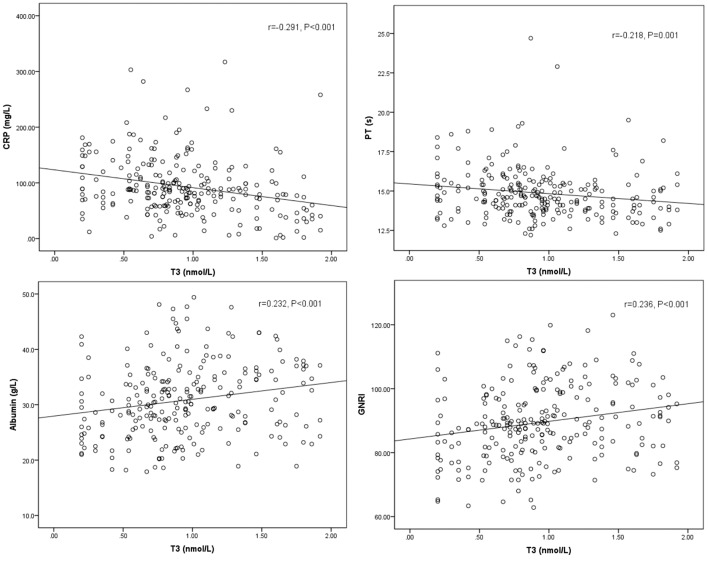
Scatter diagrams showing correlation between T3, CRP, PT, albumin, and GNRI. T3 had a negative association with CRP (r = −0.291, P < 0.001), PT (r = −0.218, P = 0.001), and positively correlated with albumin (r = 0.232, P < 0.001), and GNRI (r = 0.236, P < 0.001).